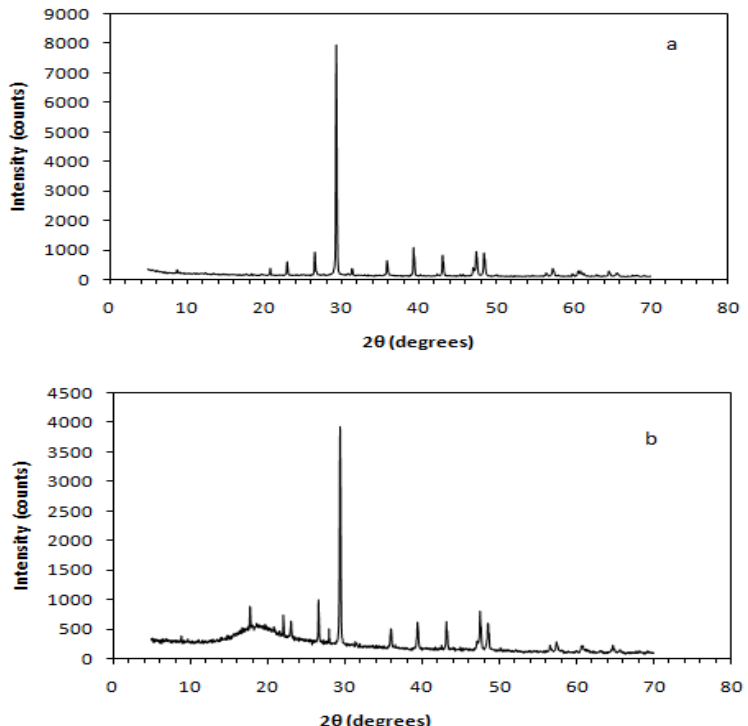
Figure 8. X-ray diffractograms of epoxy resin matrix composites ( a ) 300 μ m composites and ( b ) 500 μ m composites.